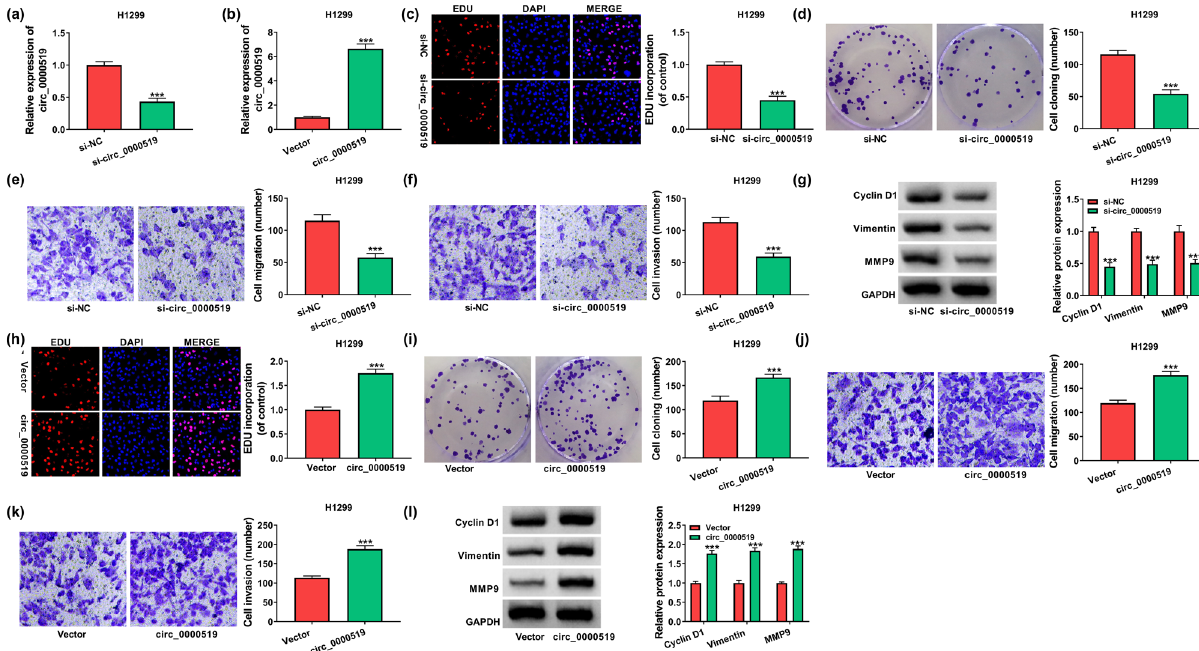
Figure 2: circ_0000519 promotes NSCLC cell growth and metastasis. ( a and b ) circ_0000519 abundance was examined via qRT - PCR in the H1299 cells with transfection of si - NC, si - circ_0000519, vector or circ_0000519 overexpression vector. ( c and d ) Cell growth was analyzed using EdU staining and colony formation assays in the H1299 cells transfected with si - NC or si - circ_0000519. ( e and f ) Cell migration and invasion were measured by a transwell assay in H1299 cells transfected with si - NC or si - circ_0000519. ( g ) Cyclin D1, Vimentin, and MMP9 levels were measured via Western blotting in the H1299 cells transfected with si - NC or si - circ_0000519. ( h and i ) Cell growth was detected with EdU staining and colony formation assays in the H1299 cells transfected with vector or circ_0000519 overexpression vector. ( j and k ) Cell migration and invasion were measured via the transwell analysis in the H1299 cells with transfection of vector or circ_0000519 overexpression vector. ( l ) Cyclin D1, Vimentin, and MMP9 abundances were determined with Western blotting in the H1299 cells transfected with vector or circ_0000519 overexpression vector. *** P <